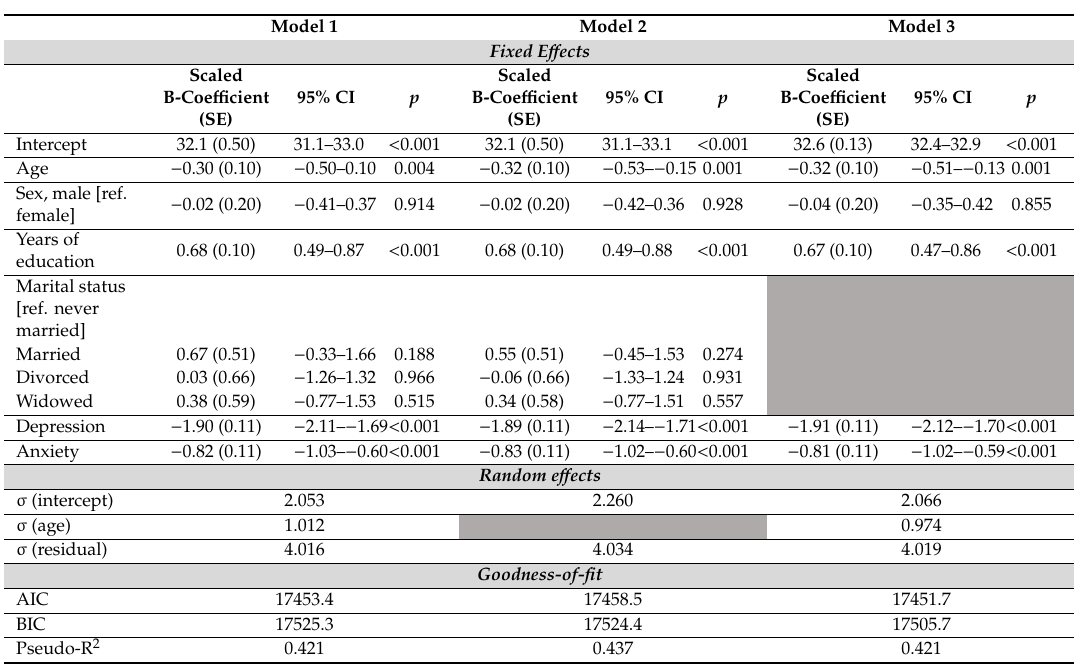
Table 2. Linear Mixed E ff ects models with predictors of